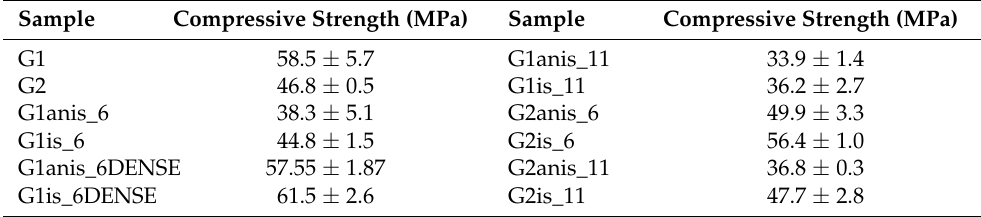
Table 9. Compressive strength data at 7 days for selected